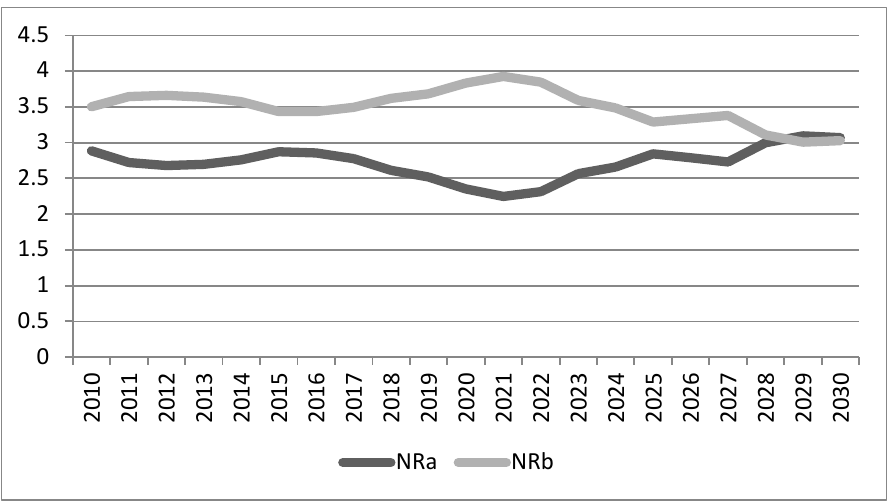
FIGURE 9: Plotting the recource holdings from 2010 to 2030, using 2010 as a base year and applying the data as per the base case scenario in the final report of the IRP 2010- 2030. data derived from the IRP 2010-2030, final